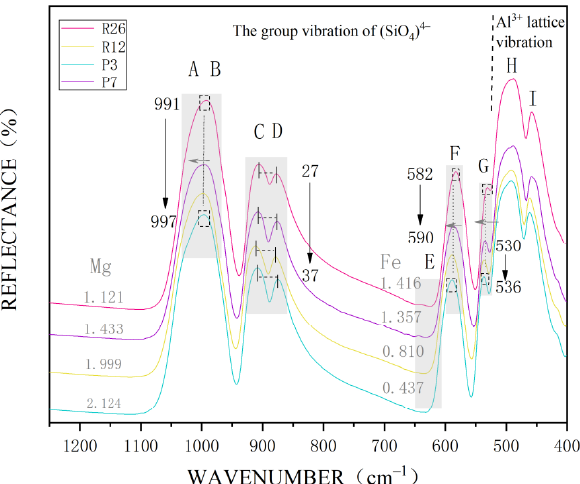
Figure 5. IR absorption spectra of four faceted pyrope-almandine shows systematic variations according to their iron and manganese contents. The wave number of A–G bands alter to be larger with the increase of manganese. The E band doesn’t occur due to the pyrope-rich